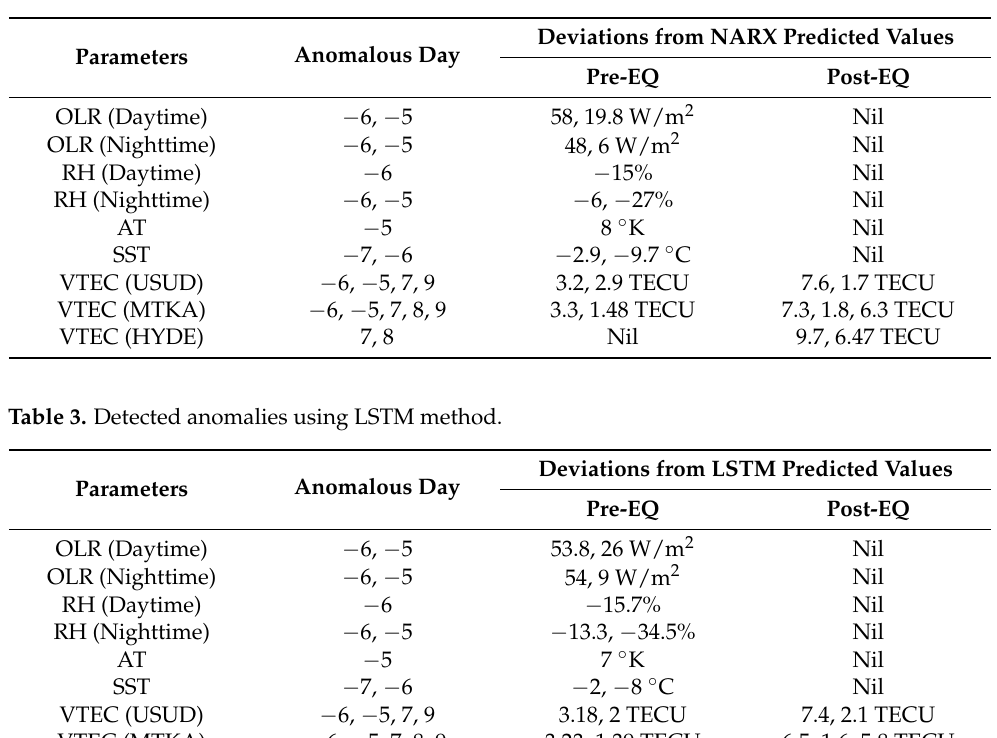
Table 2. Detected anomalies using NARX model.